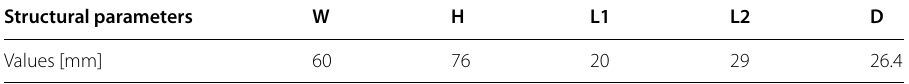
Table 1 Structure parameters of the antenna Structural